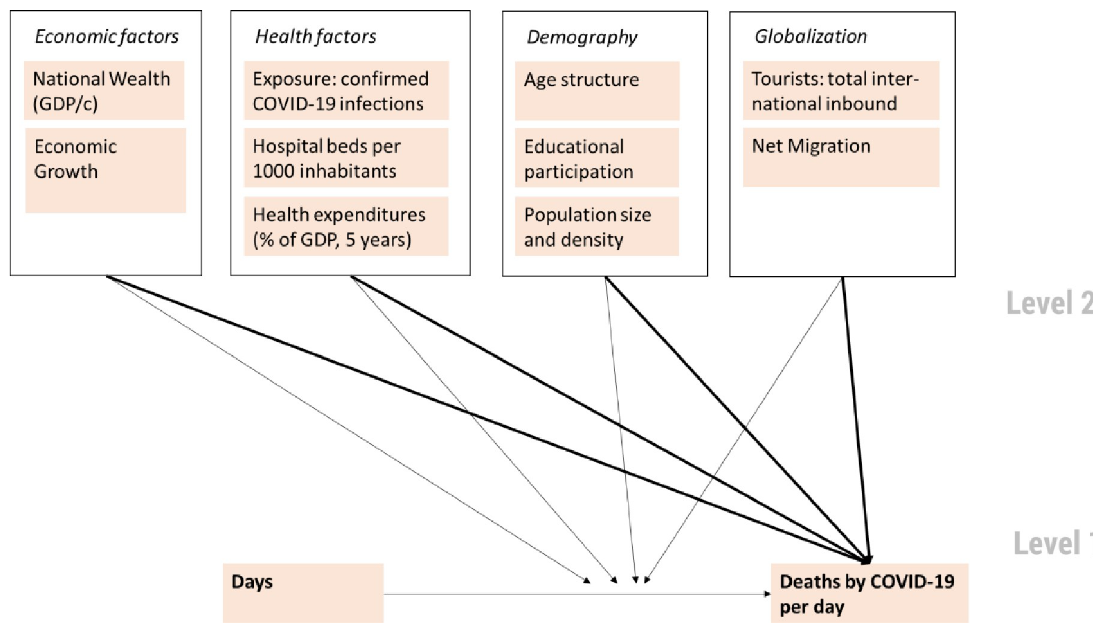
Fig 1. Analytical multi-level